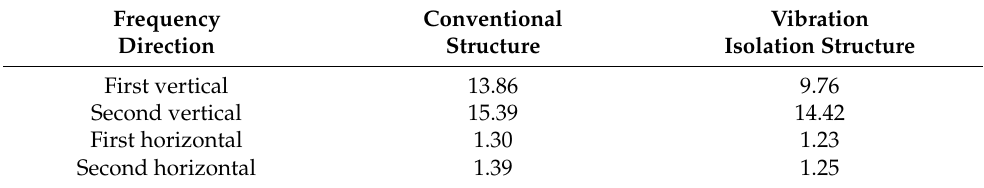
Table 5. Structure natural frequency (unit: Hz).